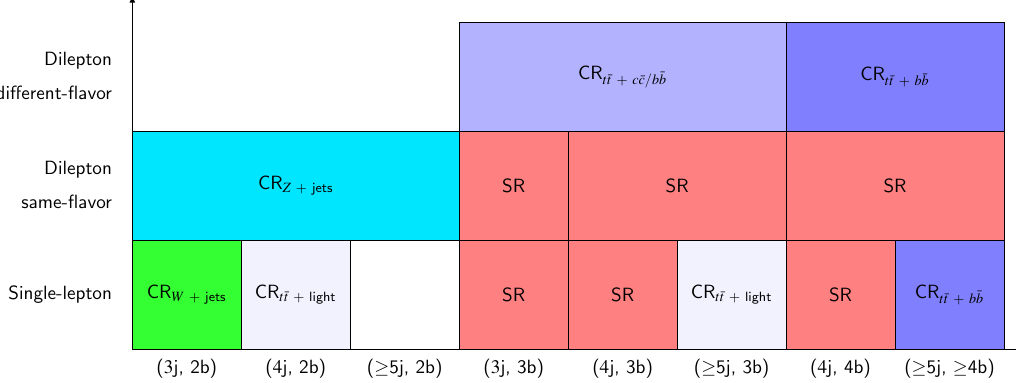
Figure 2. De(cid:12)nition of the signal and control regions (SR and CR, respectively) in the single- lepton and dilepton channels. The main background component probed with the CR is indicated. The vertical axis shows the lepton selection, while the horizontal axis shows the jet and b -tagged jet